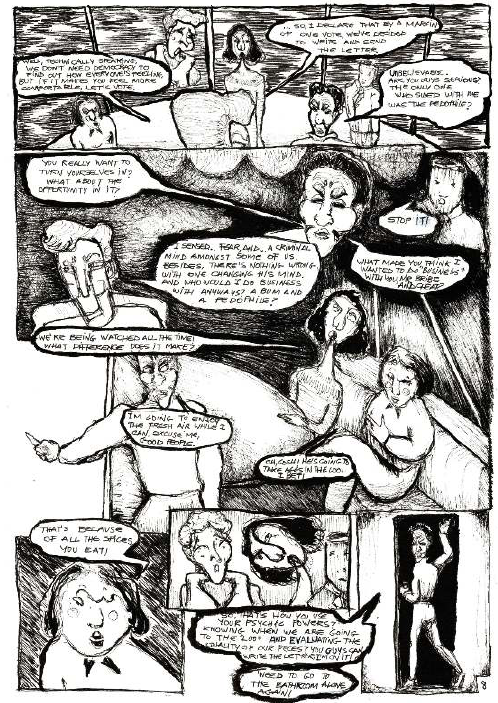
Figure 9: Plate 8, Diamond Princess II